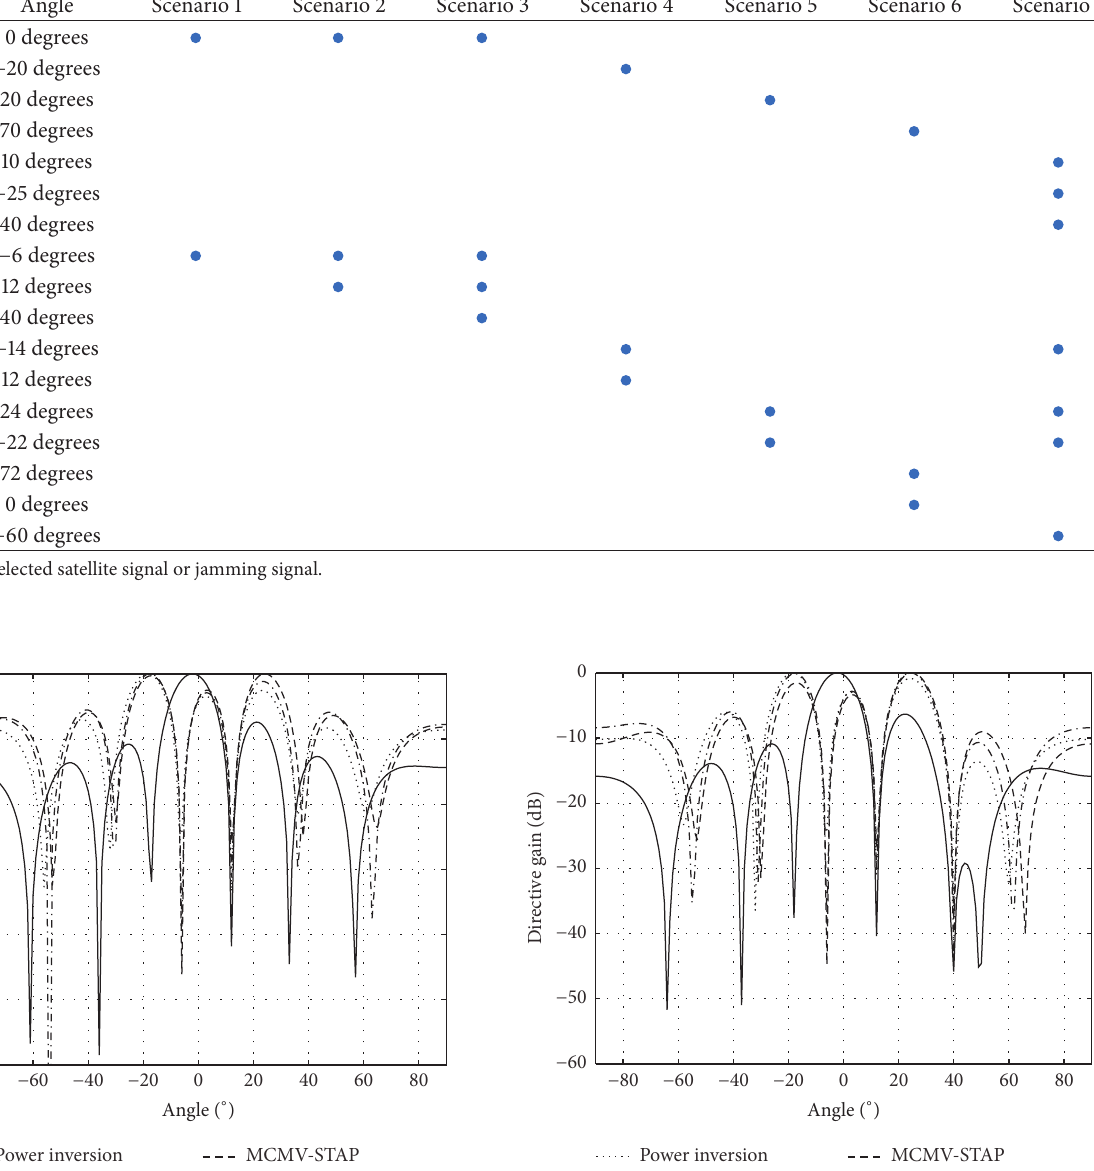
Table 1: Satellite and Jamming Scenarios.